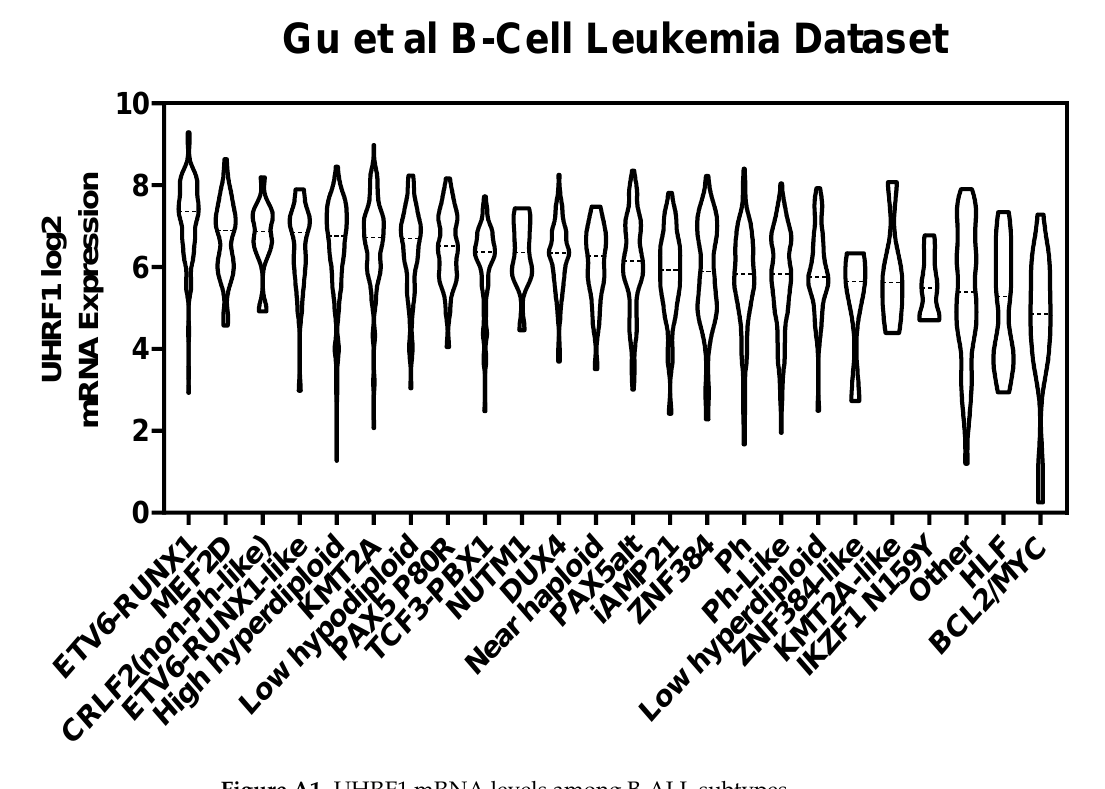
Figure A1. UHRF1 mRNA levels among B-ALL subtypes.